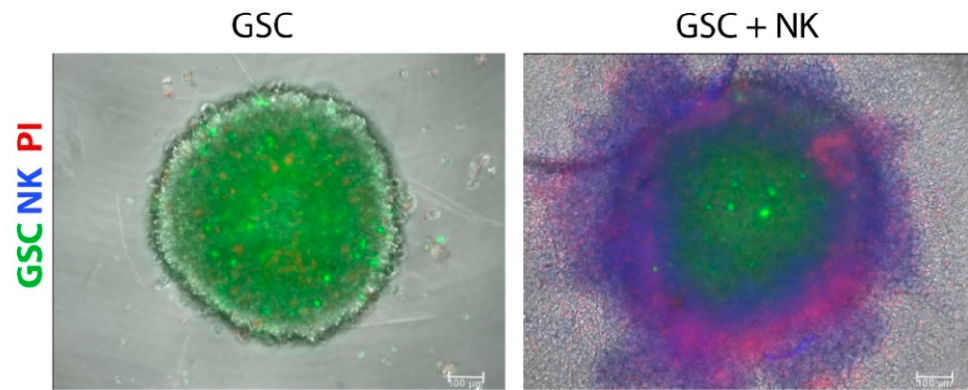
Figure 1. Super-charged natural killer (NK; blue) cell treatment decreased the number of glioblastoma stem cells (GSCs; green) and increased the number of dead cells (PI, red) in 3D tumorsphere models. NK cells were added to GSC tumorspheres at a NK:GSC ratio of 10:1, and images were acquired using an inverted fluorescence microscope 4 h later. Propidium Iodide (PI) staining was used to detect dead cells (red). Scale bars: 100 µm.